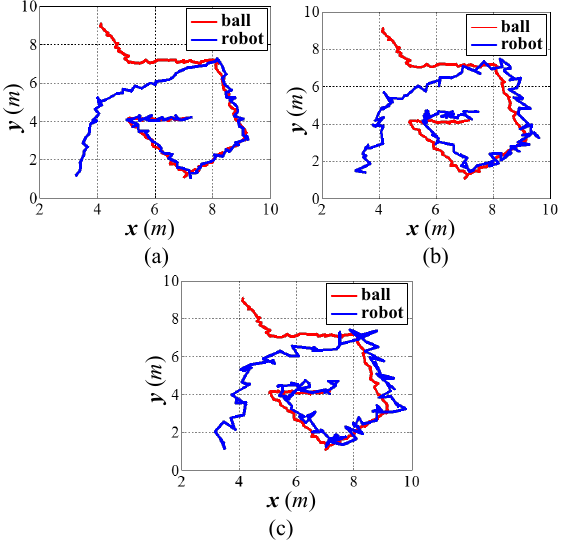
Fig. 18. Ball tracking photo sequence in simulation. Table 5. Comparison of dribbling ball